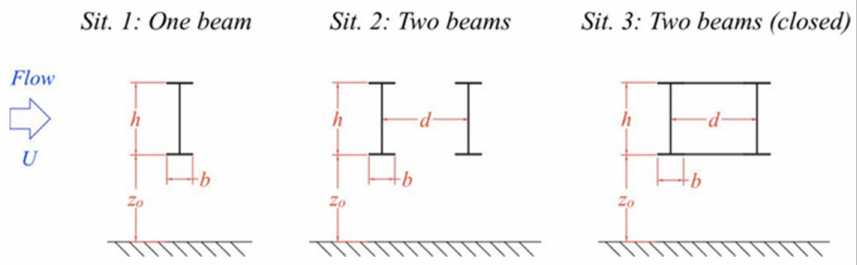
Figure 2. Construction stages considered in the parametric study (single or double column, B&W in the printed